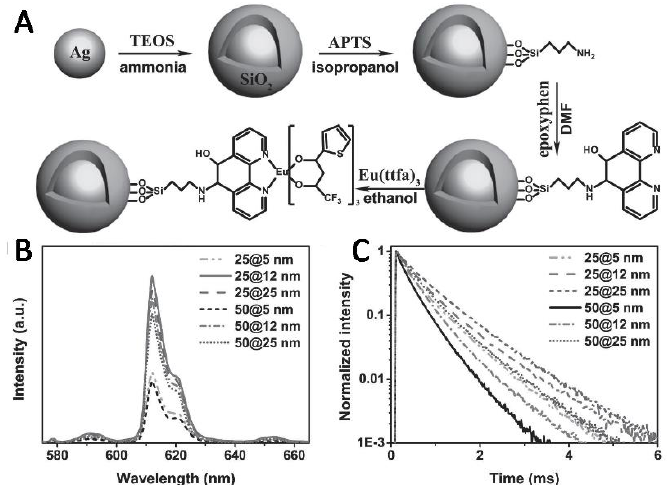
Figure 4. ( A ) The sketch map of Eu chelate grafted onto Ag@SiO 2 nanoparticles (NPs). ( B ) The co-responding luminescence spectra of samples with a 25 nm Ag core. ( C ) The lifetime of samples. Reference [99].